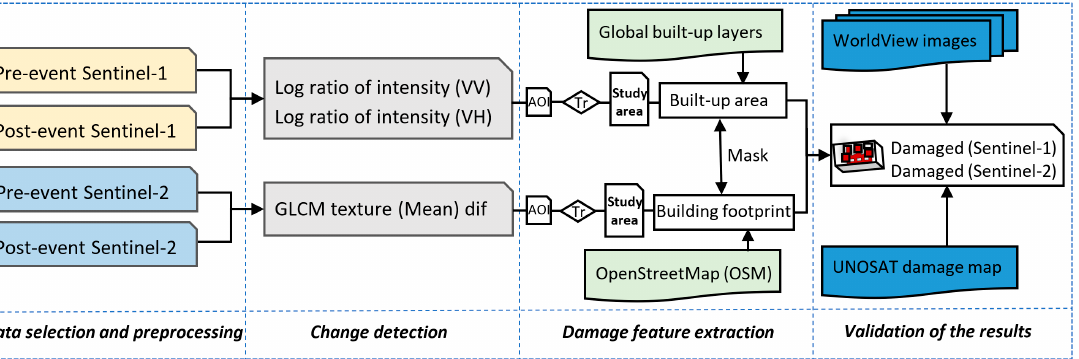
Figure 4. The processing workflow for building damage mapping using Sentinel-1 and Sentinel-2 images. Note: dif, AOI, and Tr refer to the difference, selected area for threshold determination, and threshold.